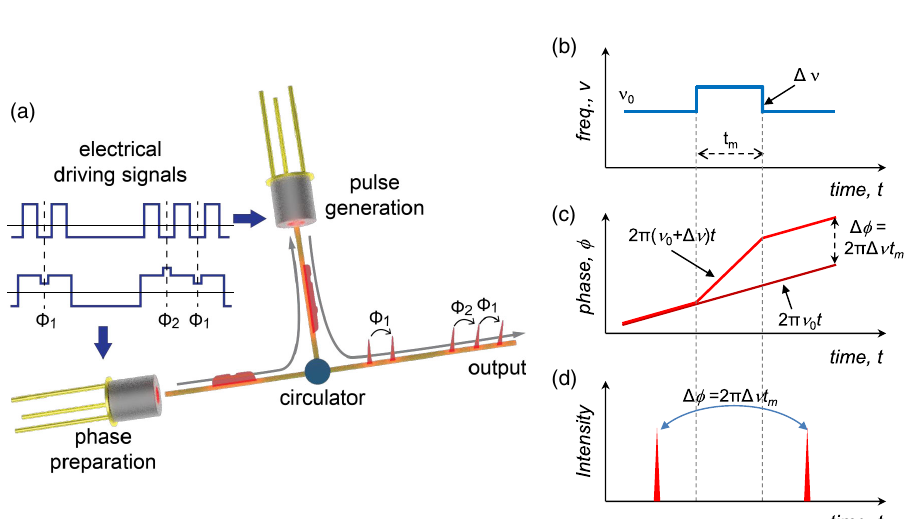
FIG. 1. Directly phase-modulated light source. (a) The source consists of a pair of semiconductor laser diodes connected via an optical circulator. We refer to these laser diodes as the phase-preparation and pulse-generation lasers. The phase-preparation laser is biased to produce nanosecond scale, quasi-steady-state optical pulses with shallow intensity modulation, which also modifies the optical phase. The gain-switched pulse-generation laser emits short optical pulses which inherit the optical phase prepared by the phase-preparation laser. The duration of each phase-preparation laser pulse can be varied to seed a pulse train of different lengths. (b) The optical frequency of the phase-preparation laser under a small perturbation of duration t m . (c) Optical phase trajectories with and without the perturbation of the phase-preparation laser. (d) The phase Δ ϕ transferred to the relative phase between pulses emitted by the pulse-generation